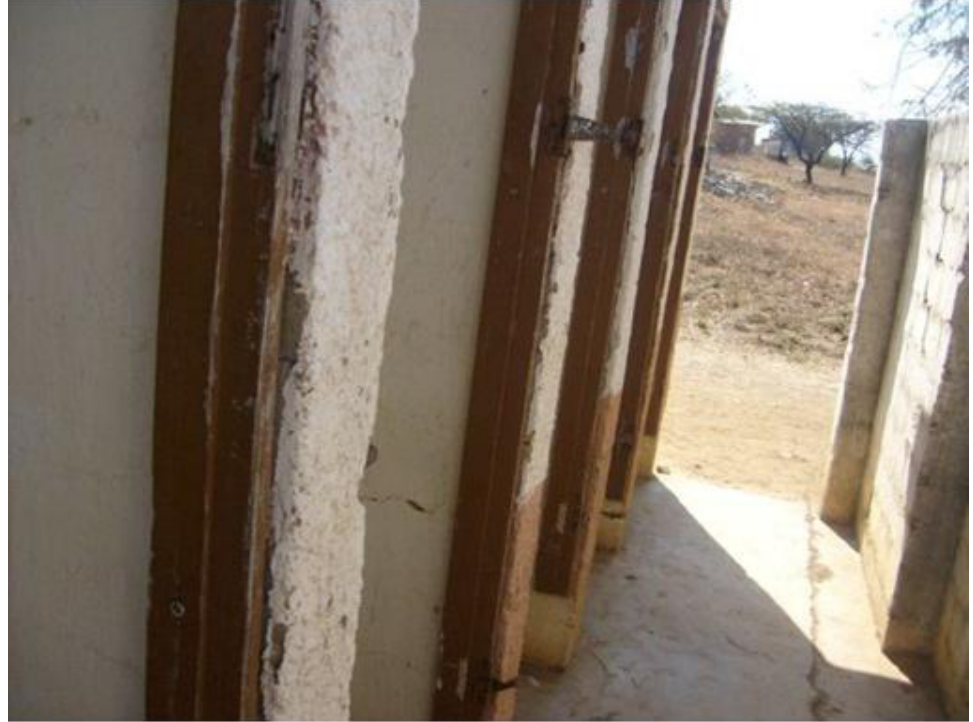
Figure 6. Sanitation facilities showing absence of